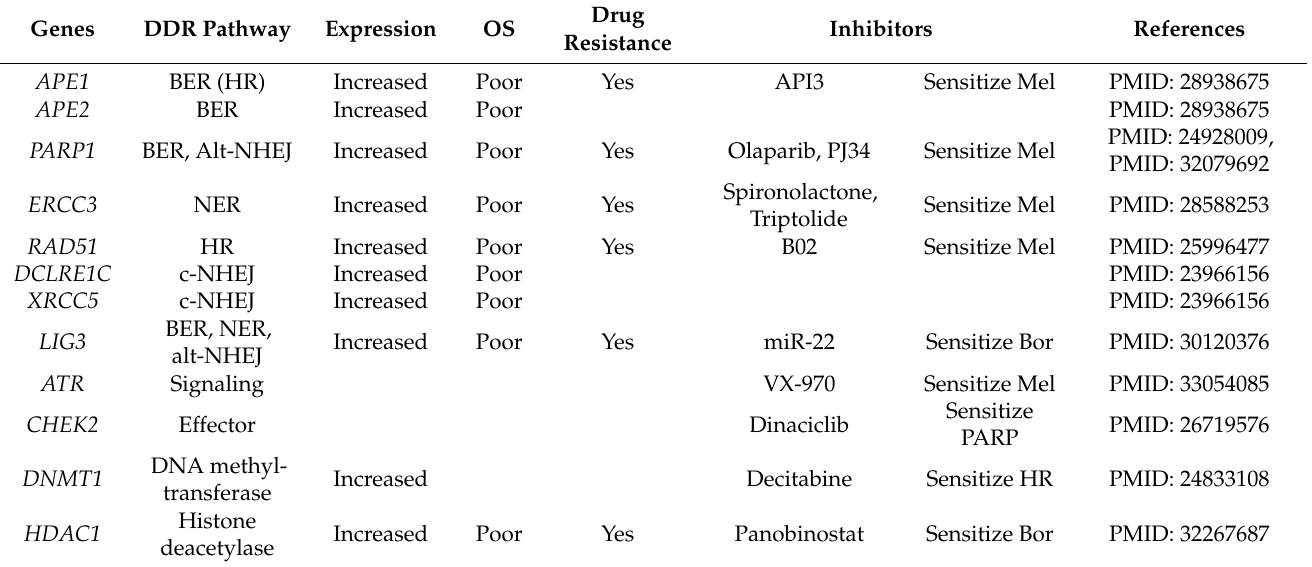
Table 2. Different DDR pathways and their associated inhibitors in